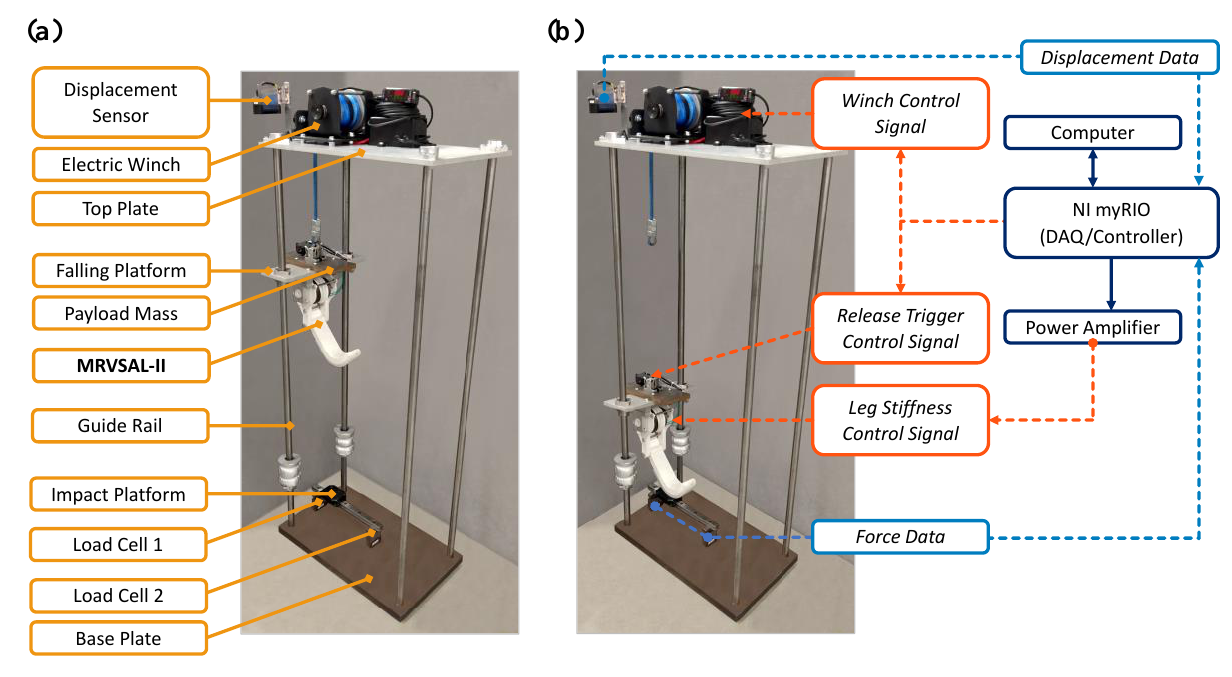
Figure 2. Impact loading experimental setup ( a ) layout and ( b ) control system.